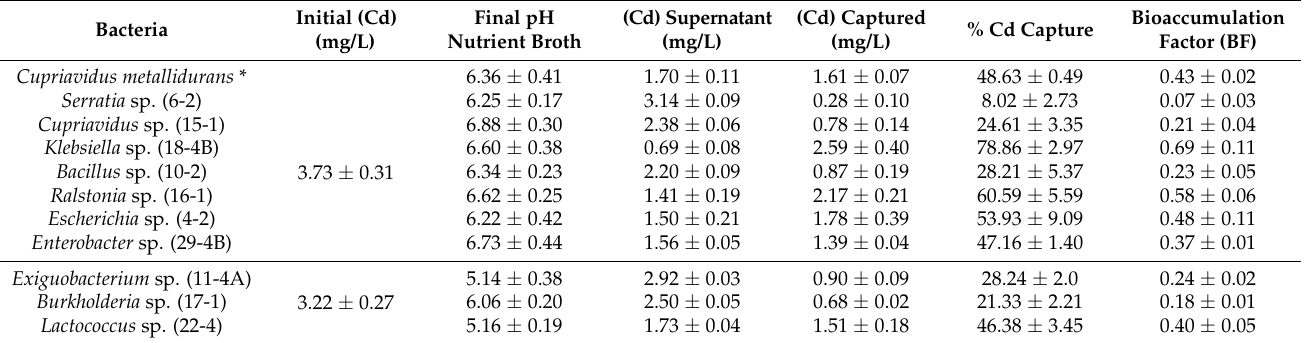
Table 3. Ability to tolerance and bioaccumulation for the native bacteria